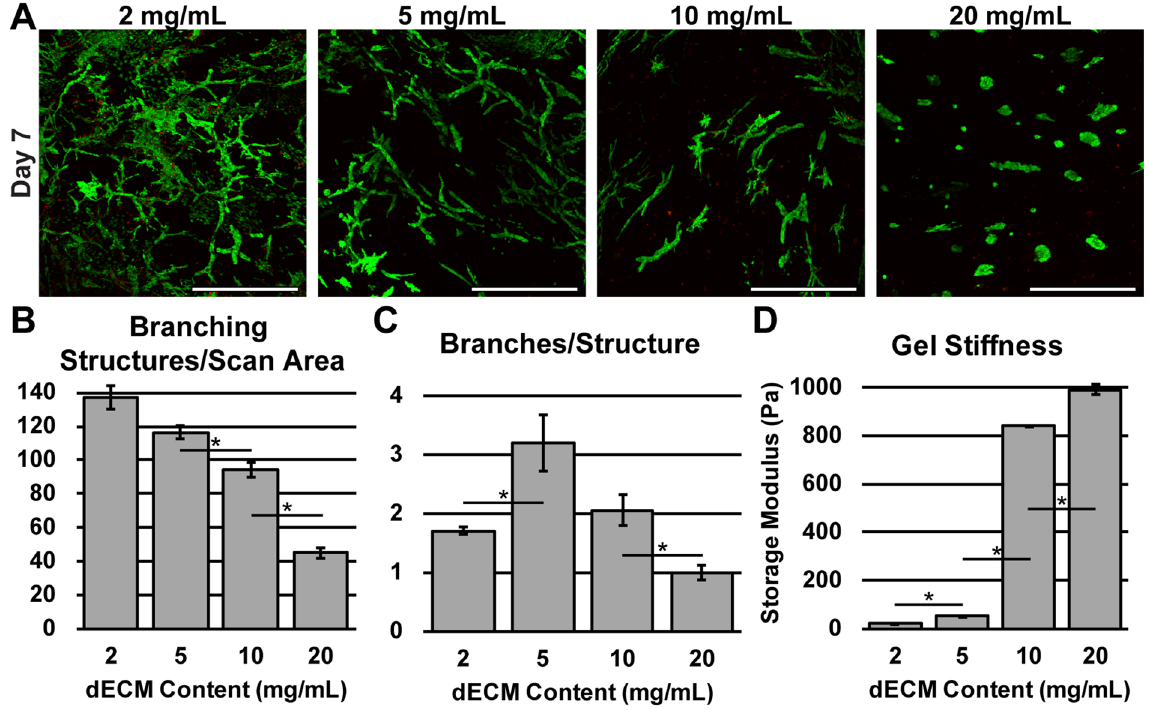
Figure 3. Liver dECM Content Influences Duct Formation. ( A ) Varying proportions of dECM influence formation of duct structures. All samples are confocal z-stack maximum intensity projections, visualized with live/dead (green/red) viability stain. ( B ) Quantified number of branching structures per image, indicating a reduction with increasing dECM content. ( C ) Quantified number of branches per structure. ( D ) Storage modulus (solid-like properties) of dECM hydrogels of different mass fractions. Error bars = ± SD, n = 3. Scale bar = 500 μ m. * p <